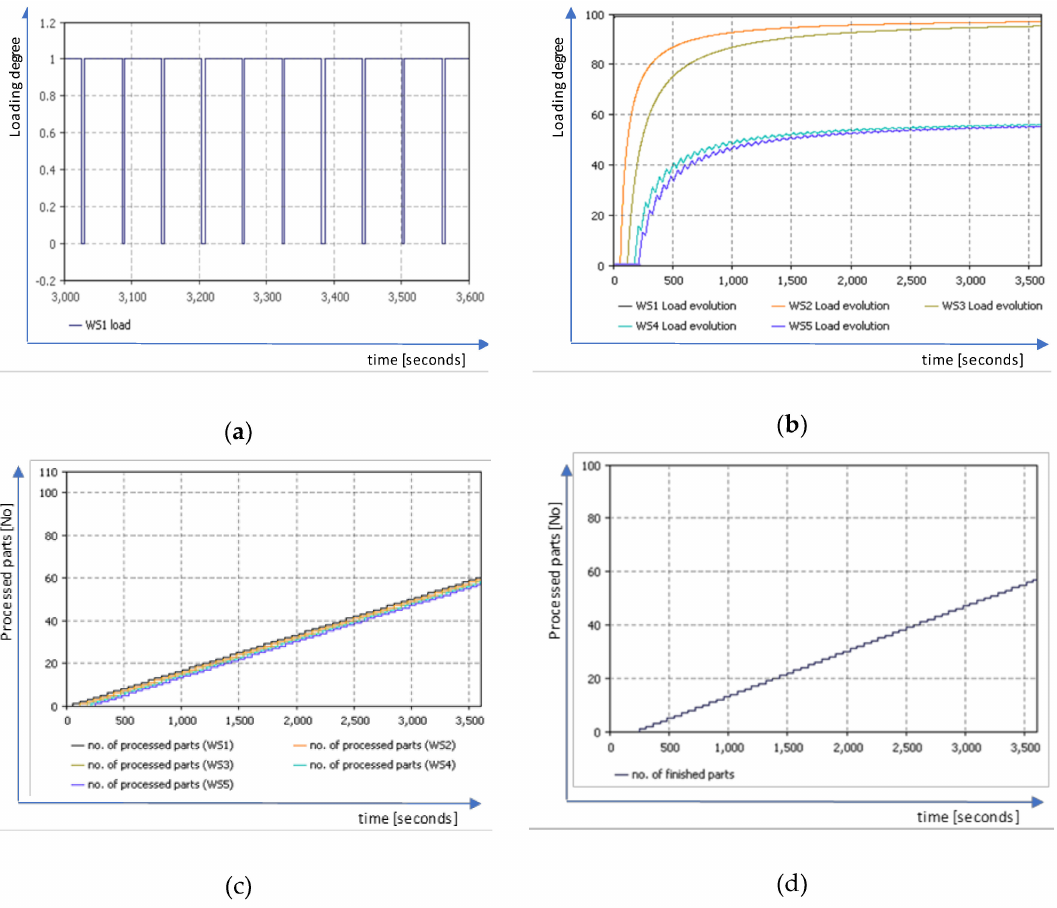
Figure 6. Simulation results of current situation: ( a ) Loading degree (per a workstation); ( b ) Loading degree per all the workstations; ( c ) Evolution of the number of processed part; ( d ) Evolution of the finished